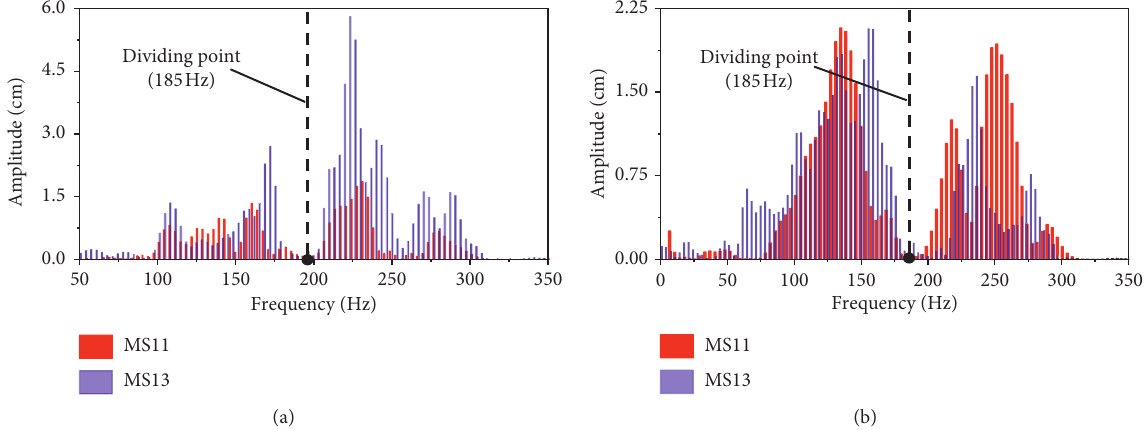
Figure 6: Amplitude spectrums of the monitored vibration waveforms. (a) Monitoring point #2. (b) Monitoring point #3.